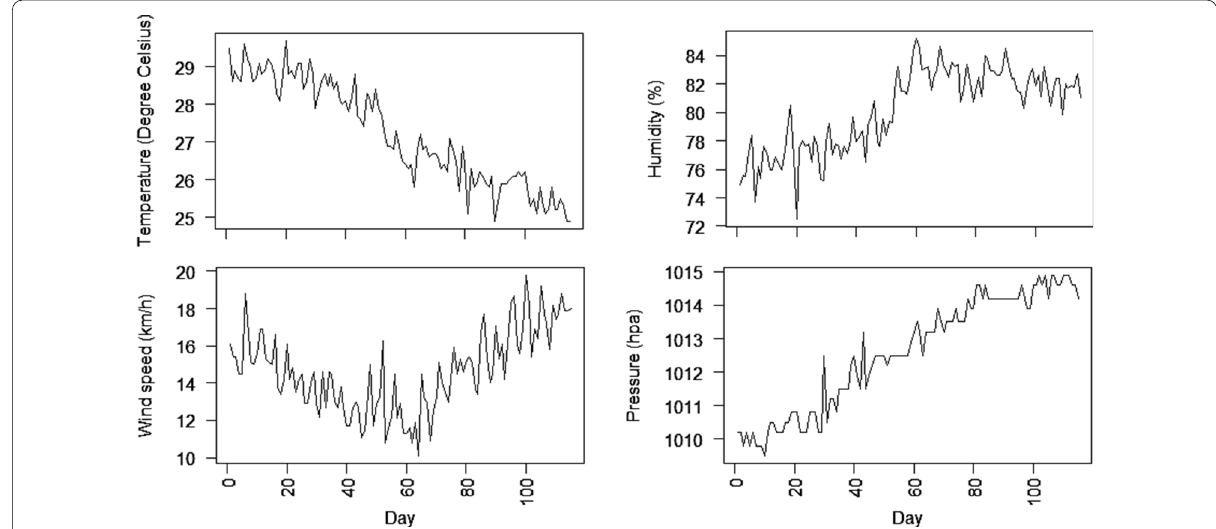
Fig. 2 Daily average temperature, humidity, wind speed and atmospheric pressure observed during the study period